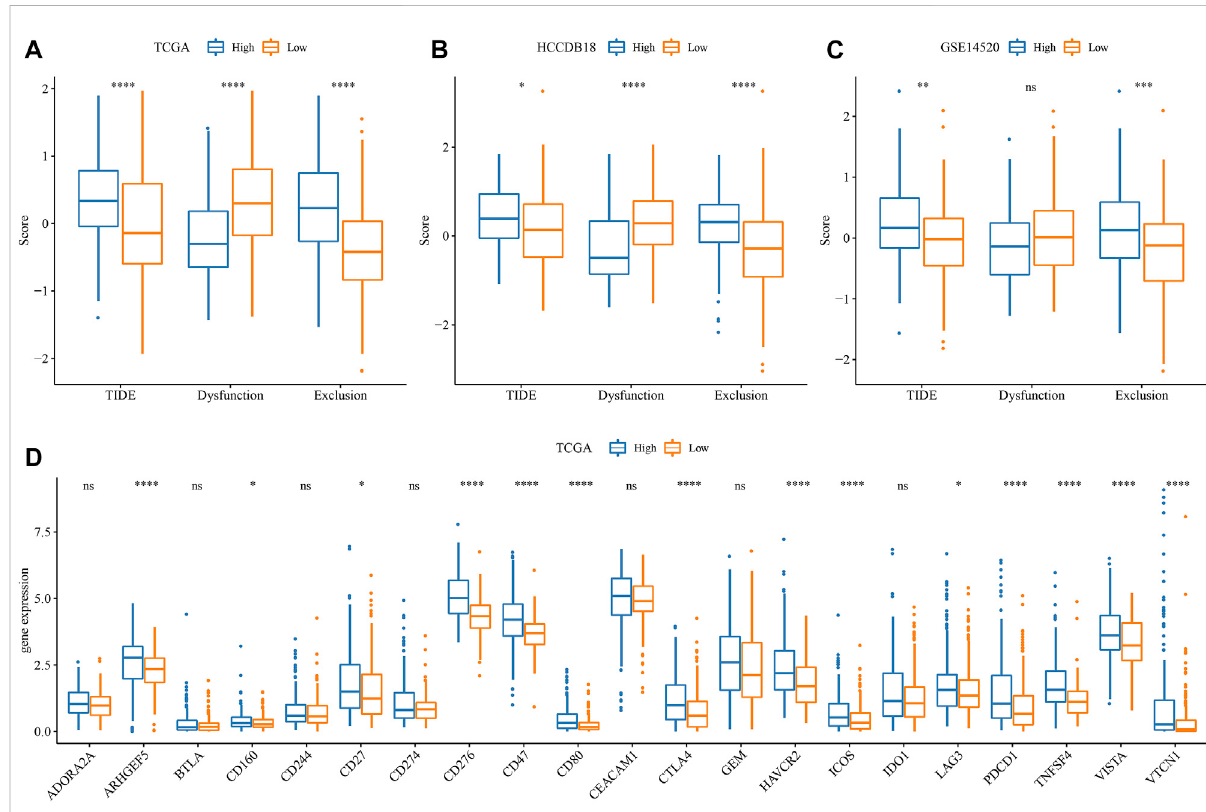
FIGURE 8 Difference analysis of immunotherapy. (A) Differences in the results of TIDE analysis among different groups in TCGA cohort; (B) Differences in TIDEanalysisresultsamongdifferentgroupsinHCCDB18queue; (C) DifferencesinTIDEanalysisresultsamongdifferentgroupsinGSE14520queue; (D) ImmunecheckpointsdifferentiallyexpressedbetweendifferentgroupsintheTCGAcohort.(ns, p > 0.05;***, p < 0.001;**, p < 0.01;*, p <